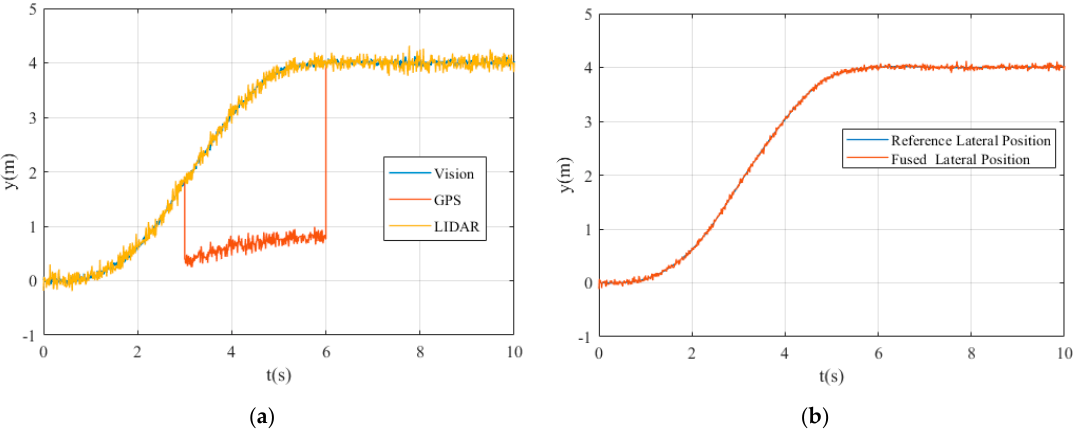
Figure 9. The lateral position: ( a ) lateral position detected using different sensors; ( b ) the reference and fused lateral position.